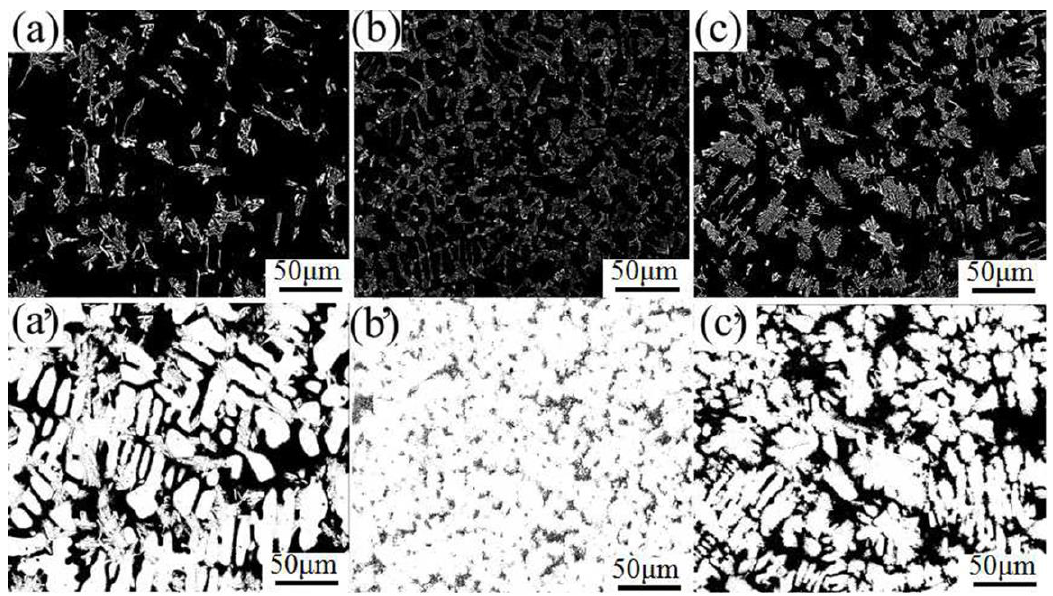
Figure 5. The SEM image after binarization processing isothermal treatment at various temperatures of Ni-Cr-W superalloy: ( a ) 1420 °C; ( b ) 1400 °C; ( c ) 1390 °C, ( a – c ) Eutectic; ( a ’ – c ’ ) γ phase.